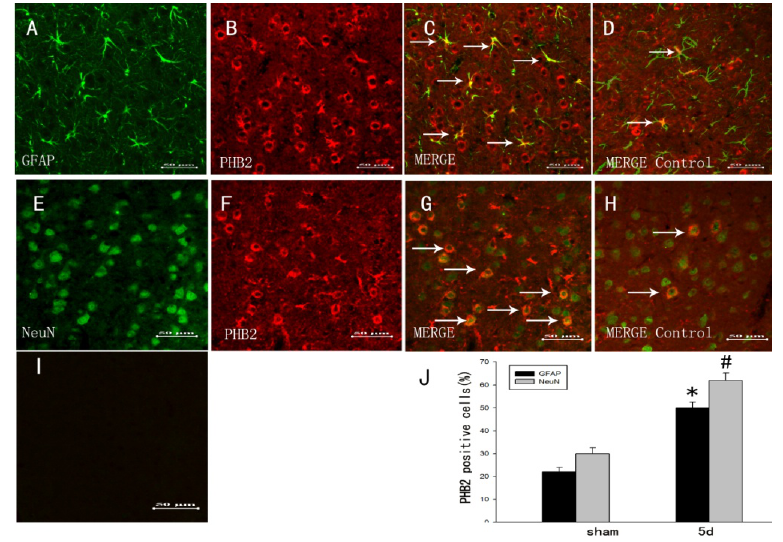
Figure 3. The colocalization of PHB2 with different cellular markers by double immunofluorescent staining. In the adult rat brain cortex within 1 mm distance from the lesion site at the fifth day after TBI, horizontal sections labeled with cell-specific markers: NeuN (a marker of neurons), and GFAP (a marker of astrocytes). We found that PHB2 was positive with astrocytes ( A – C ); Meanwhile, the positive PHB2 in neurons were also demonstrated by co-staining with anti-NeuN ( E – G ); To identify the proportion of each phenotype-specific marker-positive cells expressing PHB2, cell counting was performed in control and TBI five-day group. PHB2 expression was significantly higher in neurons and astrocytes ( C , G ) at five days compared with sham brain (Figure 3 D , H ); ( I ) Negative control. Quantitative analysis of NeuN and GFAP-positive cells expressing PHB2 (%) in the sham-operated group and day five after injury ( J ). Error bars represent SEM, Scale bars: 50 μ m ( A – I ), * p < 0.05, # p < 0.05 ( n = 3). The white arrows represent the co-expression of